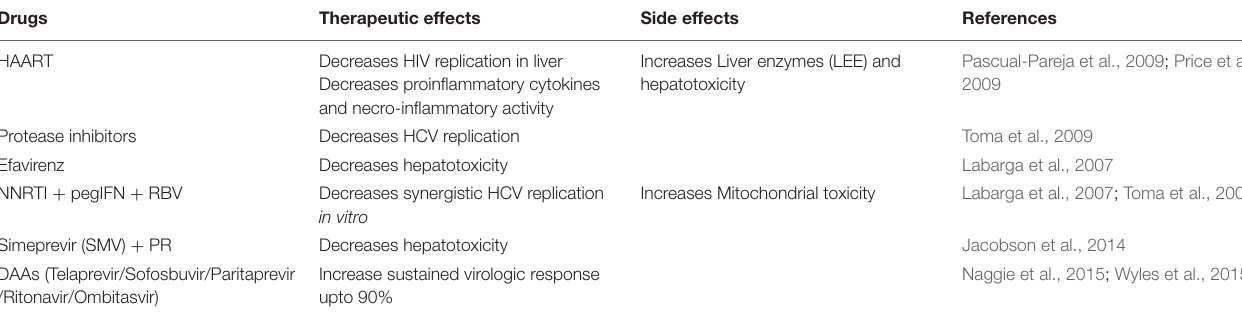
TABLE 4 | Effects and side-effects of potential medications for HIV-HCV coinfected